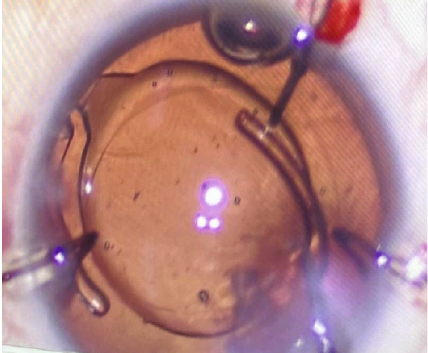
Figure 1: The lens dislocation range was about 120 degrees; the capsule hooks were fi xed on the edge of the capsule to stabilize the capsule for phacoemulsi fi cation.